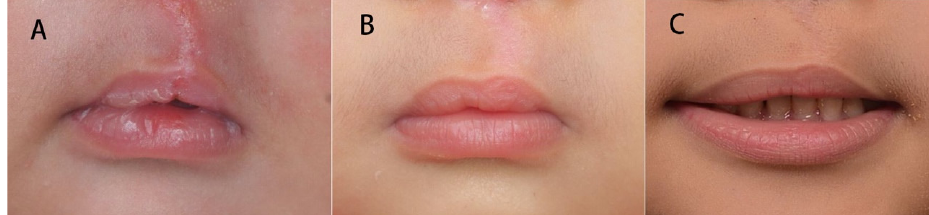
Figure 3. Vermillion change of a complete cleft lip patient. The vermillion was equal to that of the normal side 1 week postoperatively. At 12 months of age, the vermillion became excessive compared with the normal side. It gradually subsided at 5 years of age. ( A ) postoperative 1 week. ( B ) 12 months old. ( C ) 5 years old.